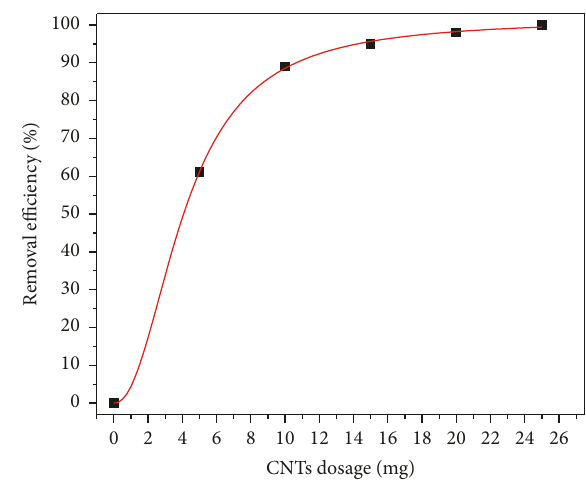
Figure 8: Effect of initial concentration of selenium on adsorption capacity of CNTs-20% iron oxide (agitation speed = 150rpm, pH = 6, CNTs dosage = 10mg, and time = 6hr).